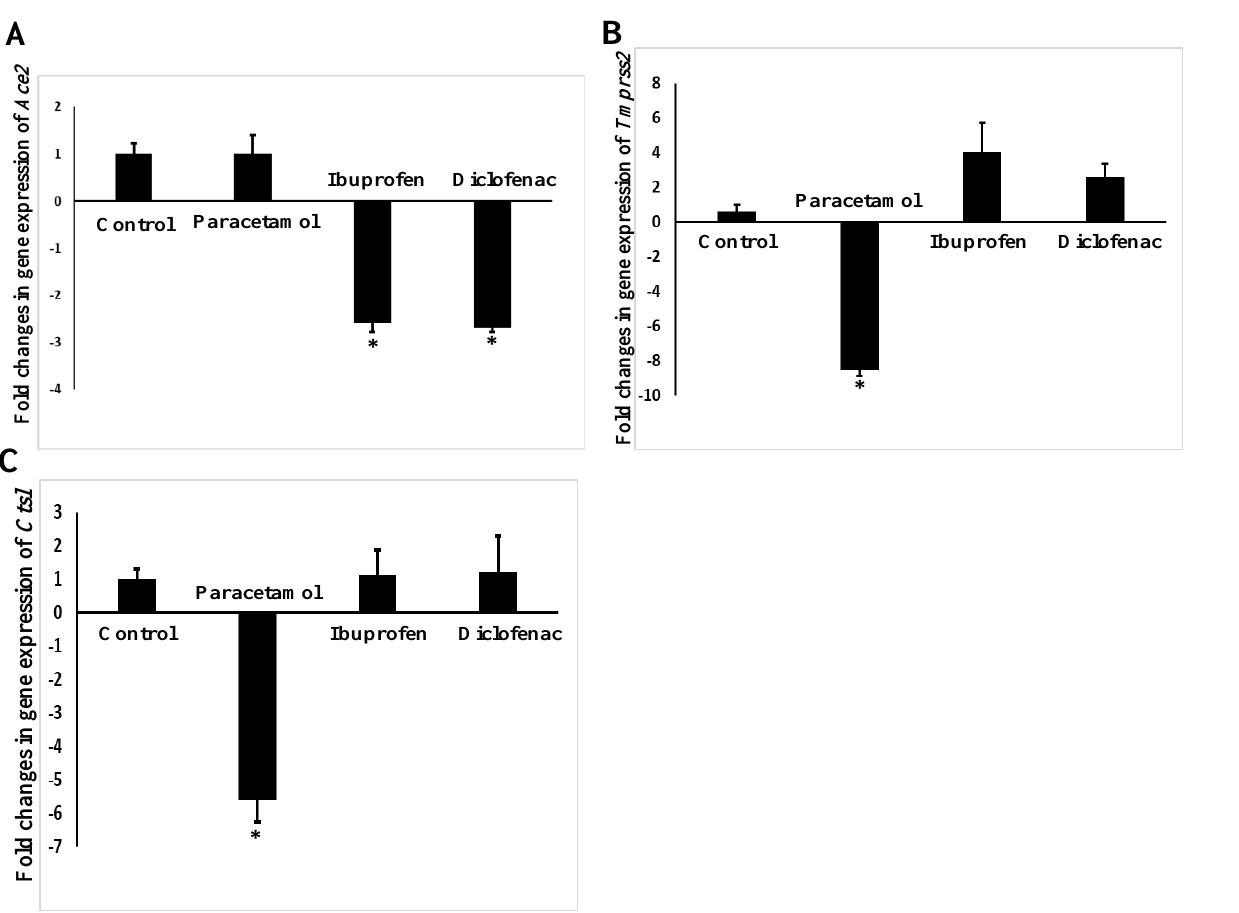
Figure 4. Expressions of SARS-CoV-2 entry genes ACE2 ( A ), TMPRSS2 ( B ), and Ctsl ( C ) in the lungs of NSAID- and paracetamol-treated mice. The mRNA expression of the targeted genes was quantified relative to Actin expression. Fold change indicates the ratio of mean expression of the NSAID- and paracetamol-treated to the control value. Negative values indicate a reduction in fold change. * indicates a statistical difference ( p < 0.05, one-way ANOVA test) in comparison with the control group.